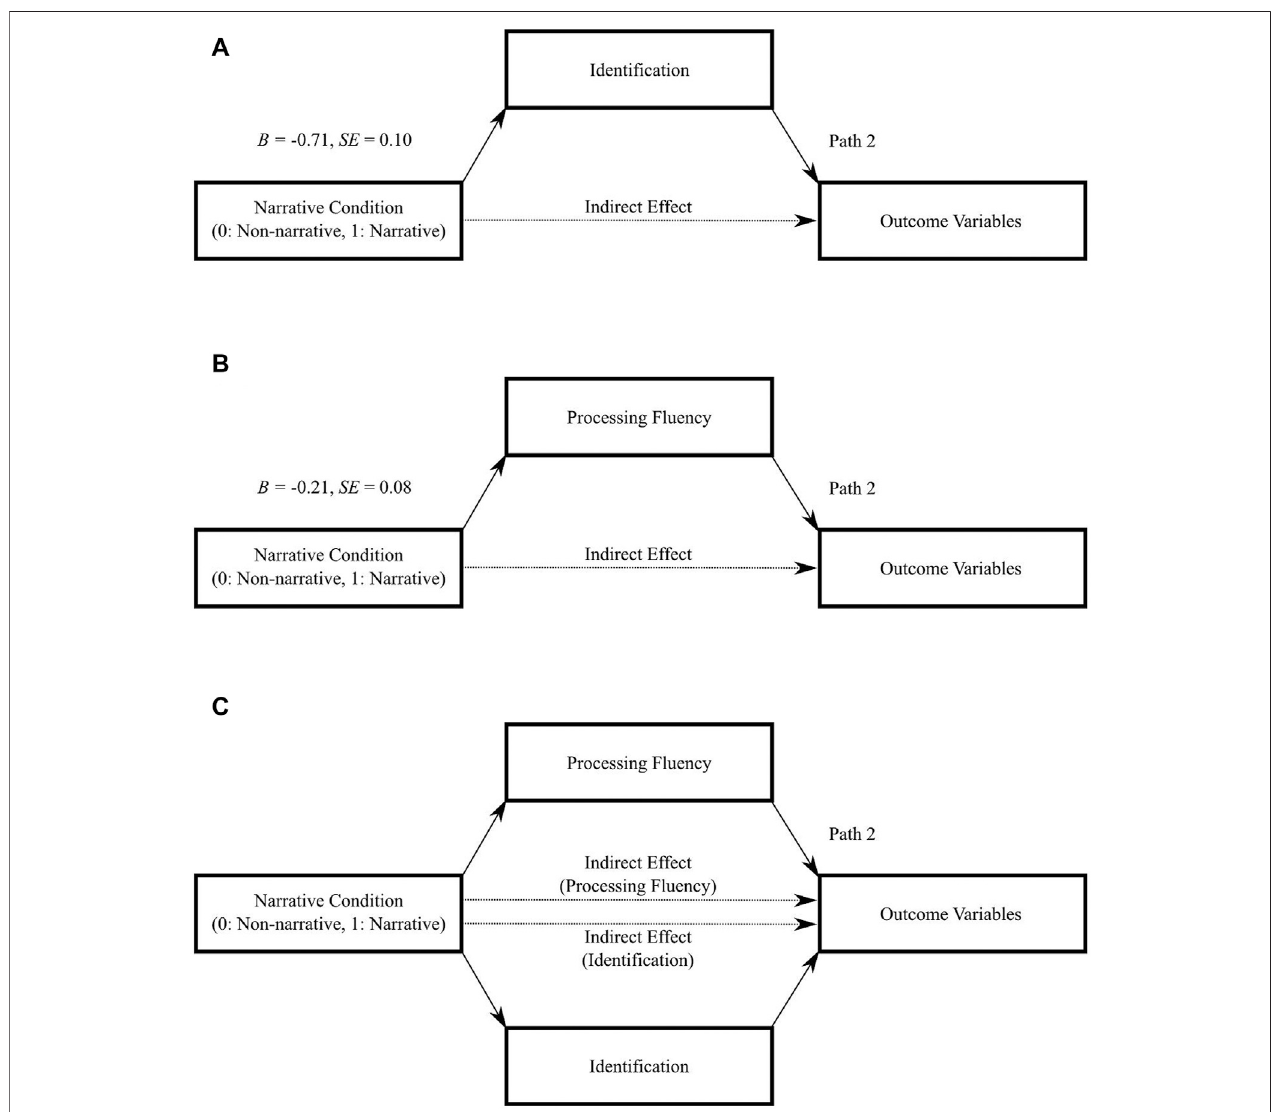
FIGURE1|(A) Theempiricalmodelassociatedwiththetestofhypothesistwoandthepathestimatesprovidedin Table1 .Thismodelwasestimated usingModel 4 (95% bias-corrected bootstrap CIs based on 10,000 resamples) from Hayes (2013) PROCESS. (B) The empirical model associated with the test of hypothesis three and the path estimates provided in Table 1 . This model was estimated using Model 4 (95% bias-corrected bootstrap CIs based on 10,000 resamples) from Hayes (2013)PROCESS (C) AtestofhypothesisfourusingModel4(Hayes,2013,95%bias-correctedbootstrapCIsbasedon10,000resamples)withthe “ contrast (cid:1) 1 ” option toggled on. Estimates are provided in Table 2